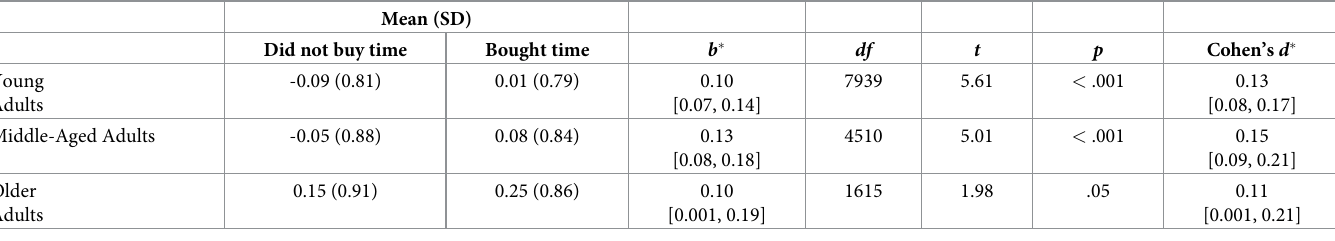
Summary . Taken together, we found limited evidence that the relationship between donat- ing to charity and SWB was moderated by demographic characteristics. With the exception of age, donating to charity was associated with higher SWB regardless of gender, personal income, and whether or not participants lived from paycheck to paycheck. Furthermore, although the relationship between donating to charity and SWB was significantly stronger among older participants, donating to charity was associated with higher SWB within each age group (including young adults and middle-aged adults). Although our data are correlational, these results suggest that the happiness benefits of donating to charity do not hinge on certain demographic characteristics.